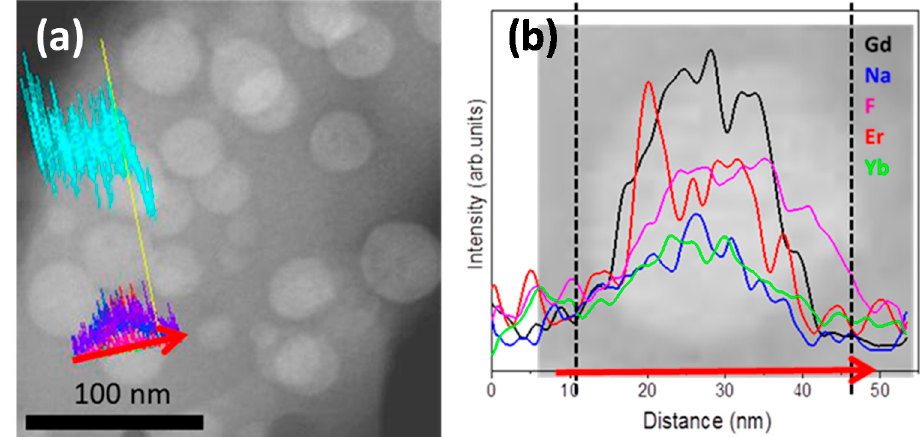
Figure 4. ( a ) Scanning transmission microscopy-high angle annular dark field (STEM-HAADF) image of 0.5Er 3+ –2Yb 3+ -codoped 70Si–7Gd GCs treated at 580 °C-120 h used for EDX analysis; ( b ) corresponding EDXS analysis along with the line scan spectra of one of the nanocrystals (NCs).